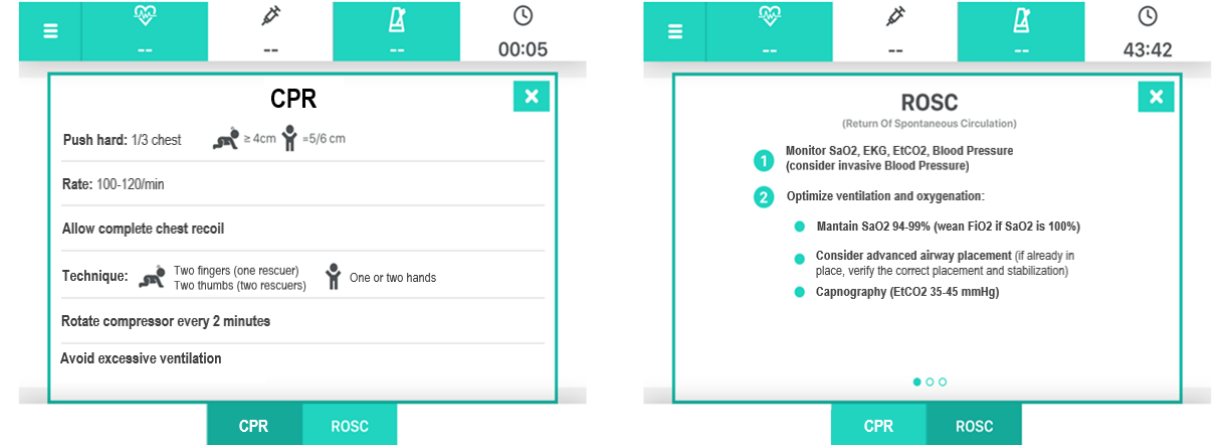
Figure 3. Cardiopulmonary resuscitation (CPR) and return of spontaneous circulation (ROSC) information. EKG: electrocardiogram; EtCO2: end-tidal